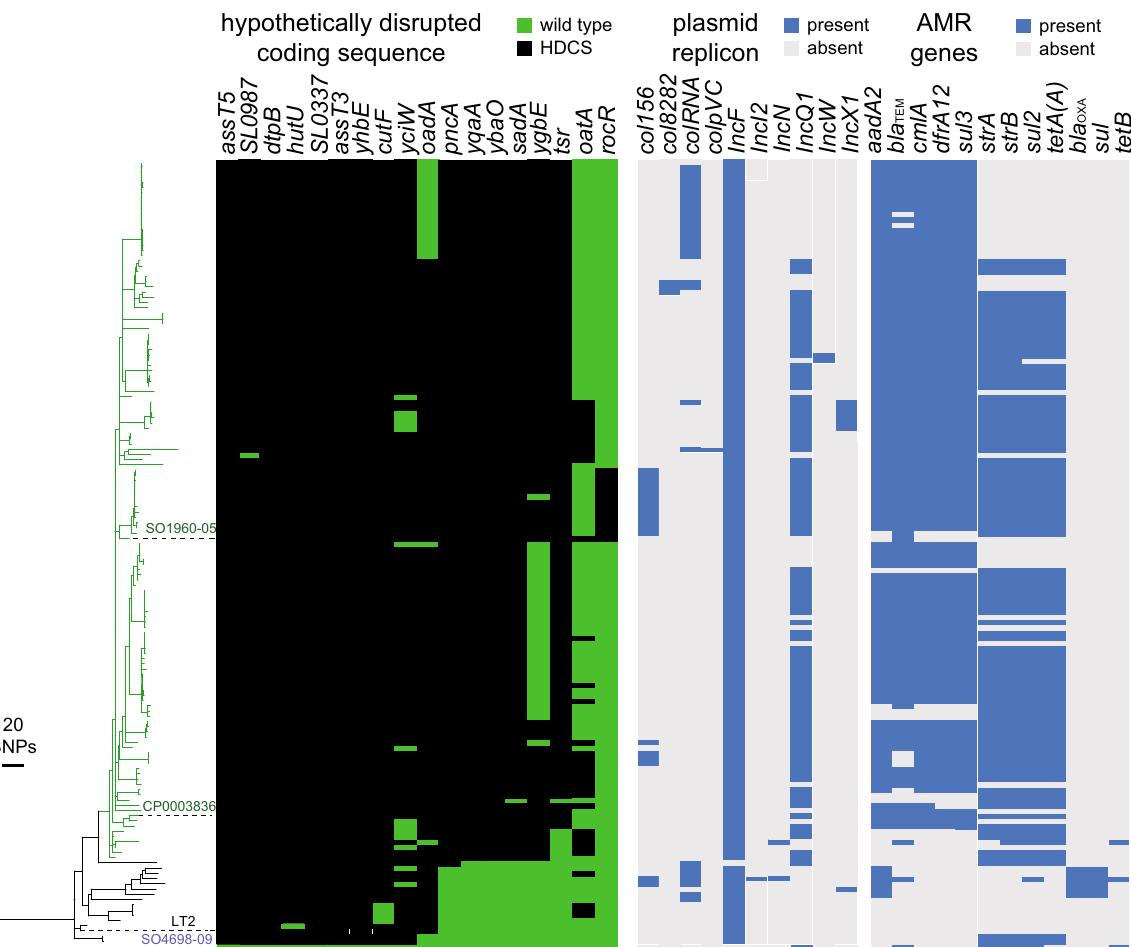
Fig. 4 Phylogenetic relationship and genotypic variation in selected genes of S . Typhimurium U288 and monophasic S . Typhimurium ST34 strain S04698-09. Mid-point rooted maximum likelihood tree based on 1859 SNPs in the recombination-purged variation in the core genome with reference to S . Typhimurium strain SL1344. Lineages associated with the U288 (green), closely related strains (black) and ST34 S04698-09 (purple) are indicated. Scale bar indicates the estimated number of SNPs based on the genetic distance as a fraction of total SNPs. This collection comprised 134 S . Typhimurium U288 isolates from animals and human infections in the UK placed in the context of 16 S . Typhimurium isolates from animals and human that were closely related but outside of the main U288 clade. Monophasic S . Typhimurium strain S04698-09 is included as an outgroup. The presence of allelic variants associated with HDCS, plasmid replicons and resistance genes are indicated by bars colour coded as indicated in the key